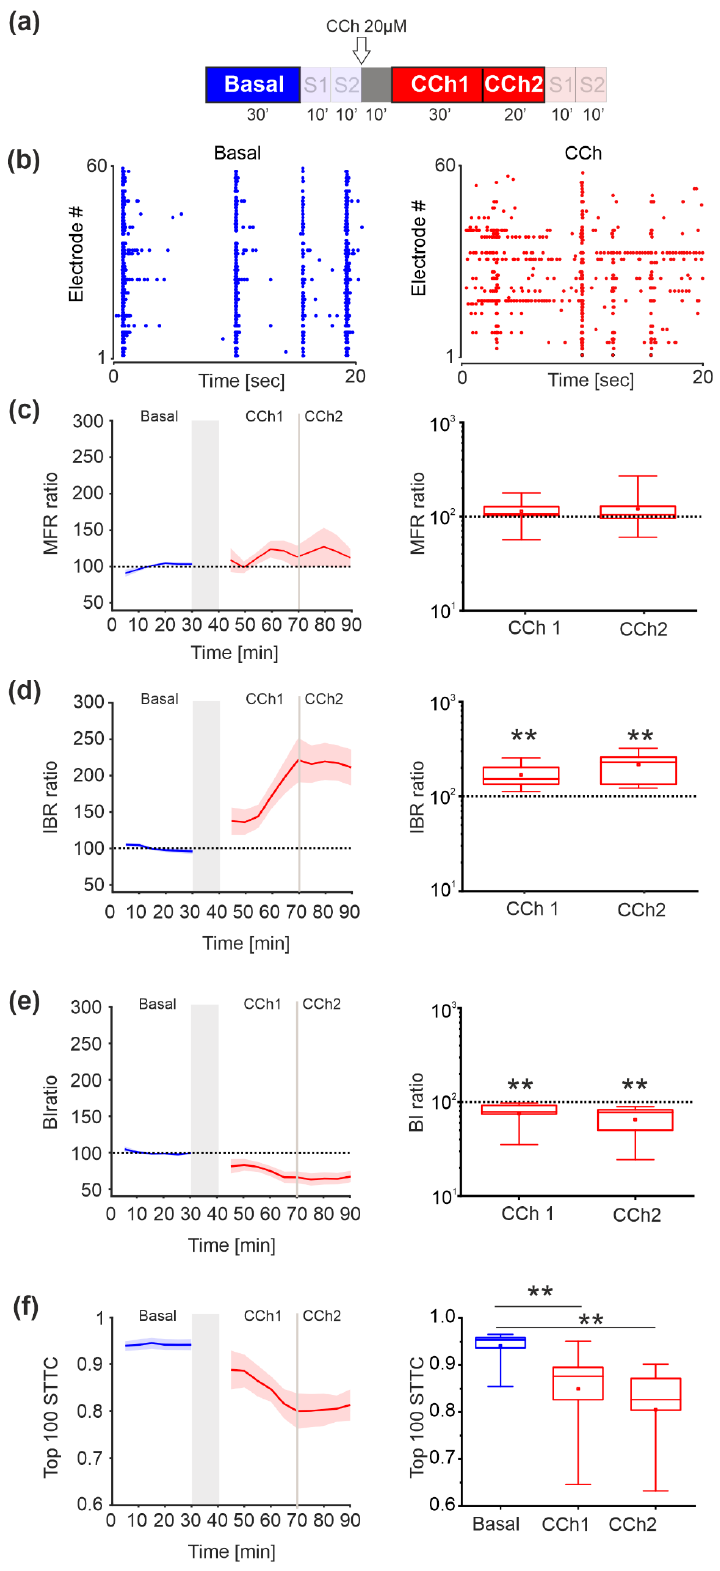
Figure 3. Comparison of the network parameters during basal and CCh administration. ( a ) Experimental protocol adopted in the experiments. The spontaneous phase (i.e., without electrical stimulation), which was analyzed here, is highlighted. Cortical cultures were recorded for 30 (cid:48) under basal conditions followed by 1 h of recording after the addition of 20 µ M CCh. CCh was evaluated at two different time